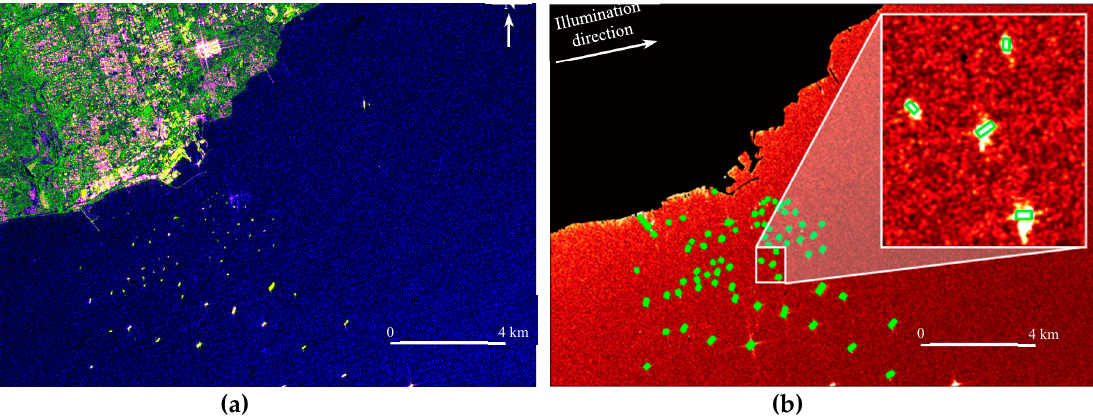
Figure 6. Automatic vessel detection: ( a ) vessels at the entrance to Port Tema, Ghana (example Sentinel-1 pseudo-colour scene); ( b ) automatic vessel detection; ( b ), inset —estimated vessels dimensions and orientation.